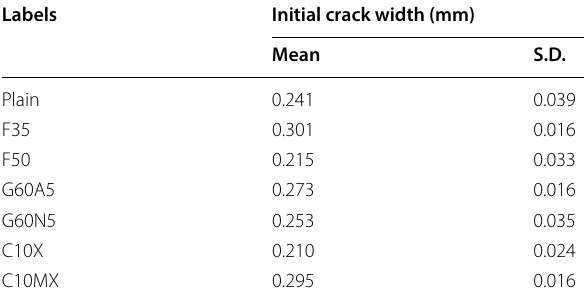
Table 4 Measured surface crack widths of